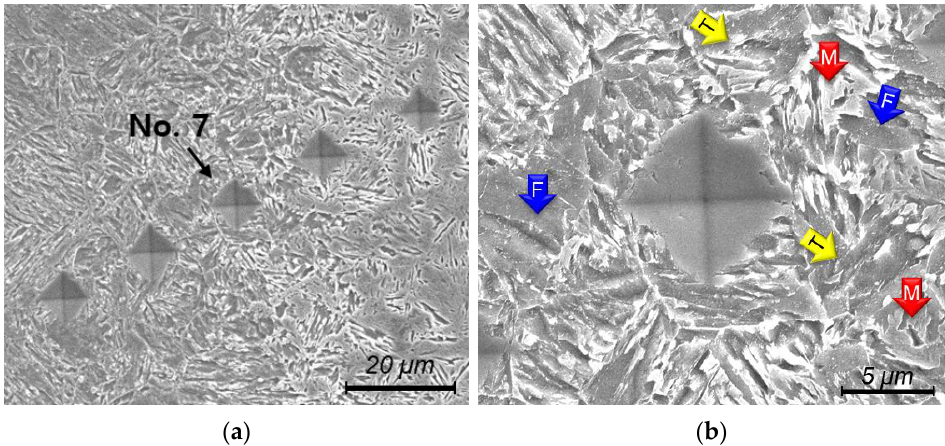
Figure 9. Microstructure around the indentation location no. 7: ( a ) 1500× magnification and ( b ) 5000× magnification (M: Martensite, F: Ferrite, T: Tempered Martensite).